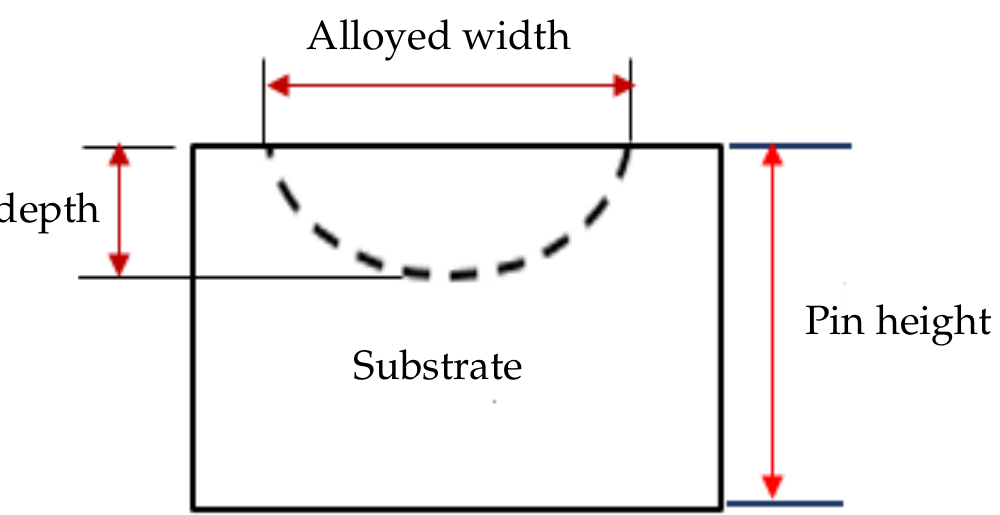
Figure 3. Schematic of pin showing the profile of the alloyed zone